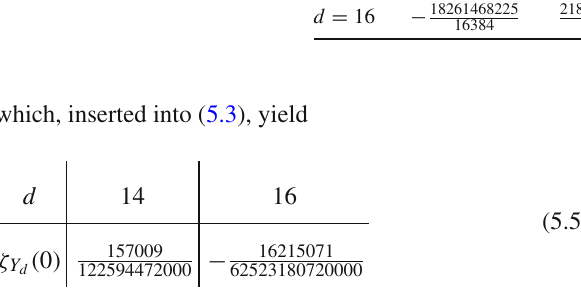
Table 2 Solutions of the linear system (5.4), for d = 14 ,